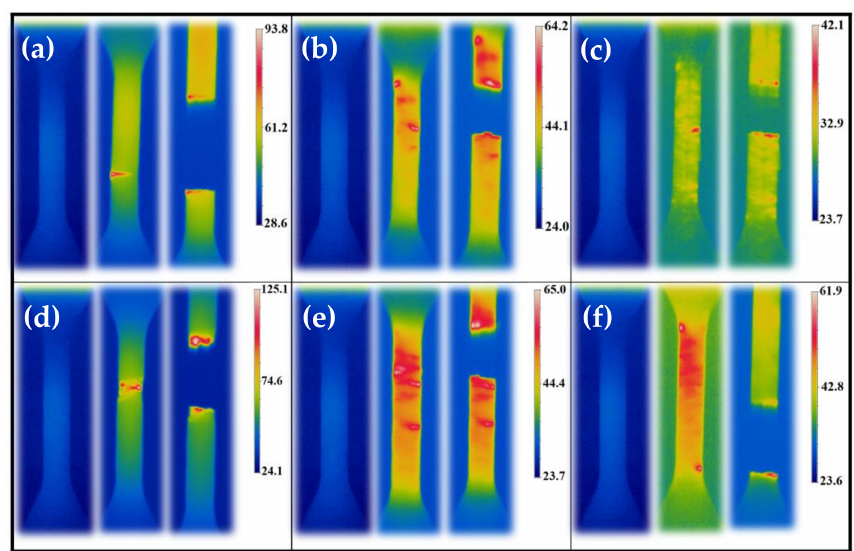
Figure 11. Induced temperature under tension–tension fatigue test for condition III-1 at ( a ) σ = 24 MPa, ( b ) σ = 40 MPa, and ( c ) σ = 52 MPa; and condition III-2 at ( d ) σ = 24 MPa, ( e ) σ = 40 MPa, and ( f ) σ = 52 MPa for frequency of 80 Hz.